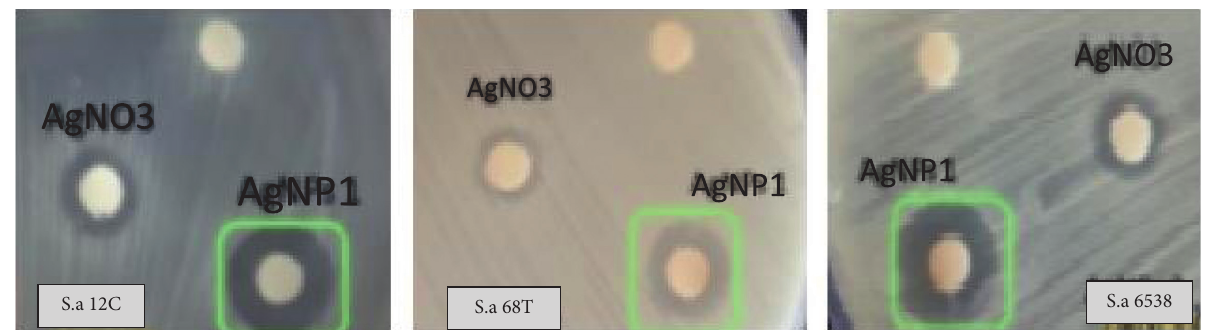
Figure 5: Antibacterial activity of silver nanoparticles (AgNP1) synthesized by reduction of silver nitrate (AgNO extract. Shown is the inhibition zone of AgNO 3 and AgNP1 against S. aureus 6538 (reference strain), S. aureus 12C, and S. aureus 68T (Tow MRSA colonizing cell